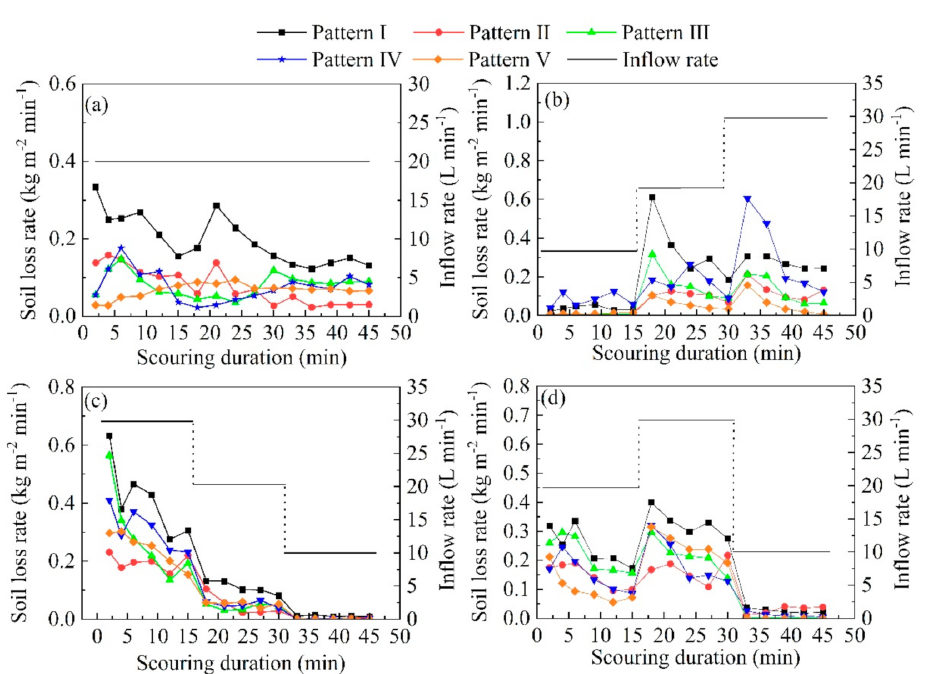
Figure 7. Changes in soil loss rate under different inflow rates for different grass strip patterns: ( a ) even, ( b ) rising, ( c ) falling, and ( d )